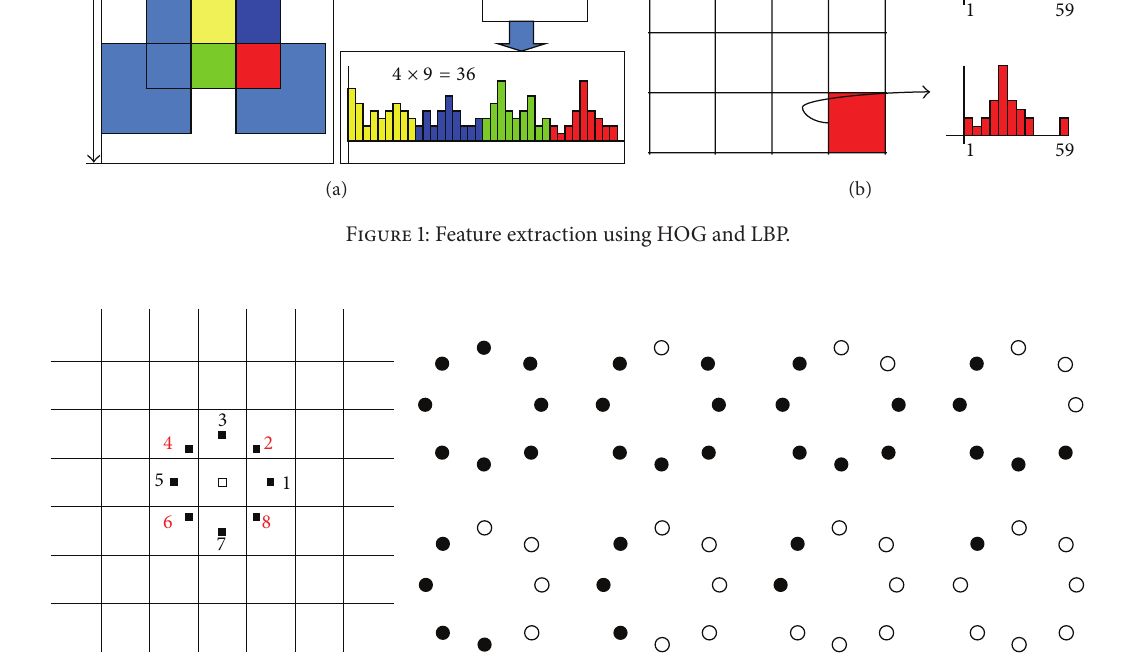
Figure 2: (a) Eight sample points of the local binary pattern; (b) examples of the uniform local binary pattern.